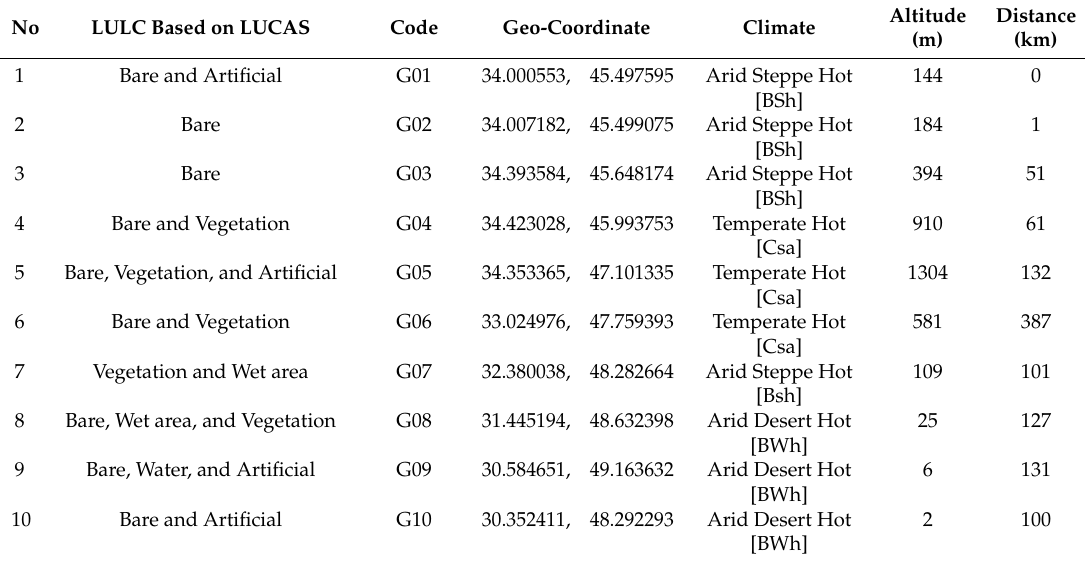
Table contents are modified based on climate pattern and adapted from